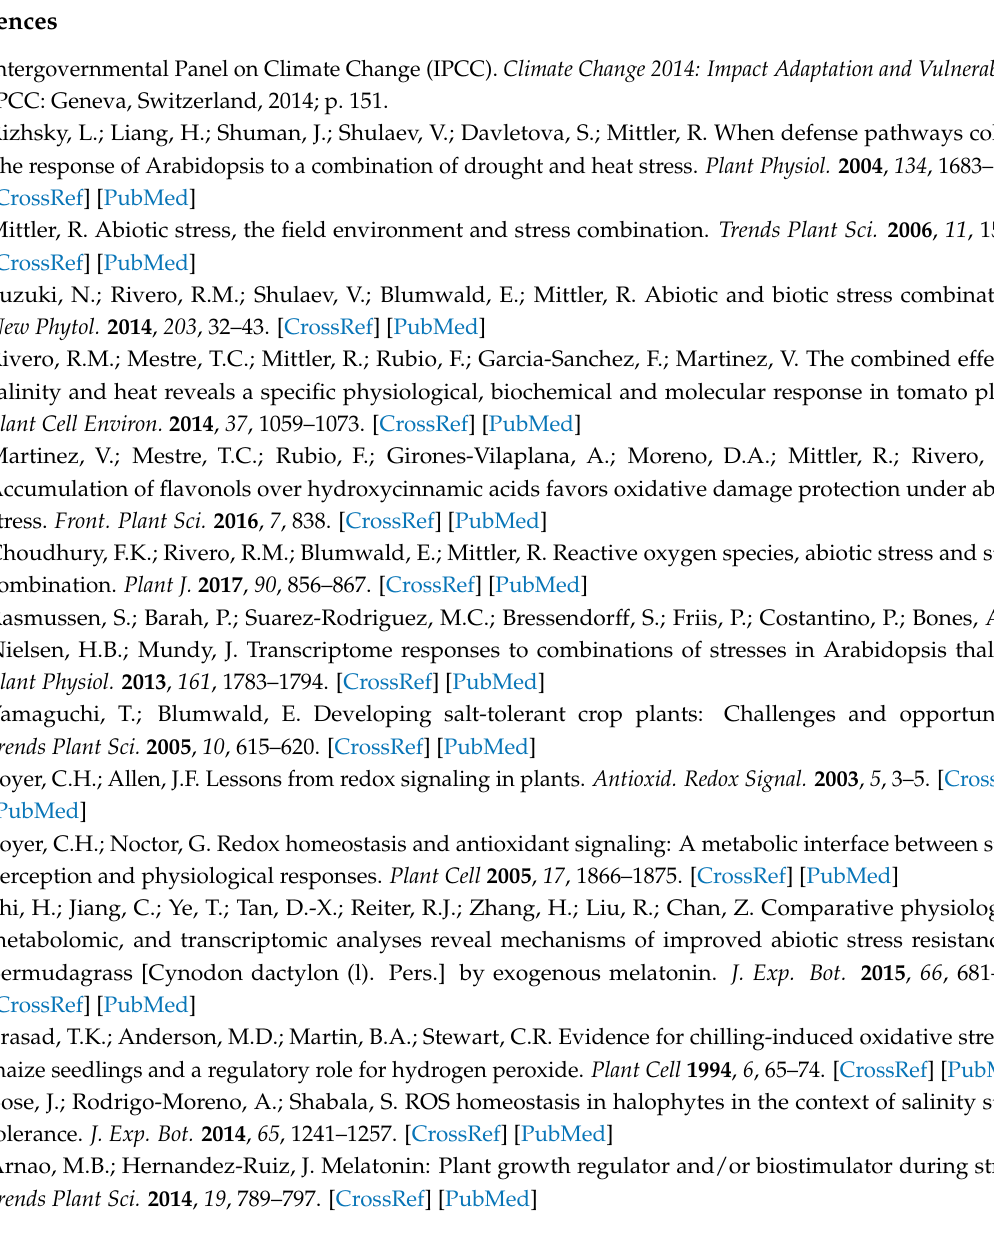
Supplementary Materials: The following are available online, Figure S1: Melatonin concentration in tomato leaves. Table S1: Primers used for qPCR experiments. Table S2: Log 2 of the expression of the oxidative metabolism-related genes. Table S3: Absolute activity of the oxidative metabolism related enzymes. Table S4: Log 2 of the activity of the oxidative metabolism-related